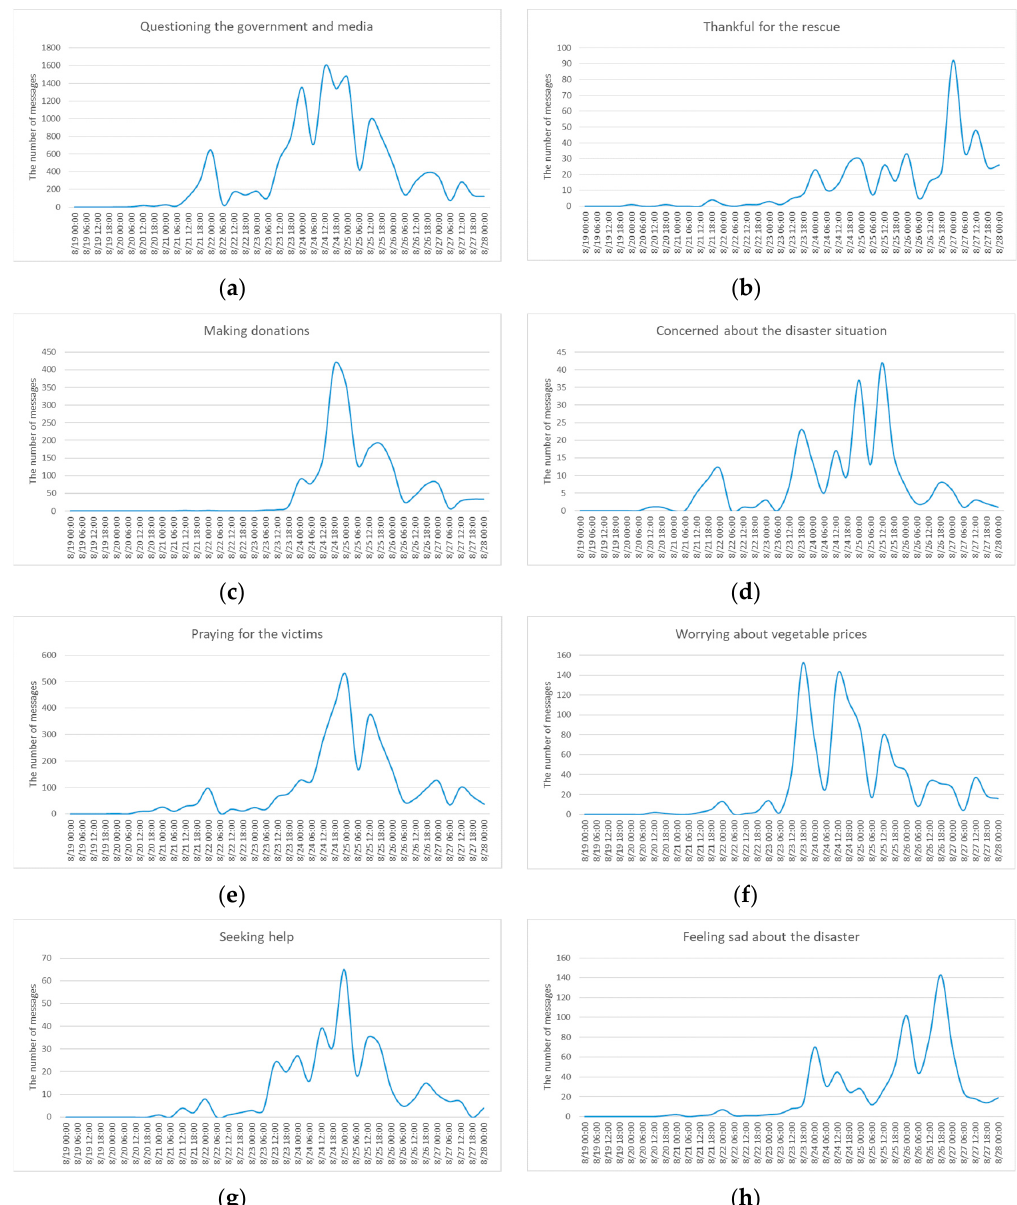
Figure 7. The trend of Weibo conveying different sentiments over time. ( a ) questioning the government and media, ( b ) thankful for the rescue, ( c ) making donations, ( d ) concerned about the disaster situation, ( e ) Praying for the victims, ( f ) worrying about vegetable prices, ( g ) seeking help, ( h ) feeling sad about the disaster.